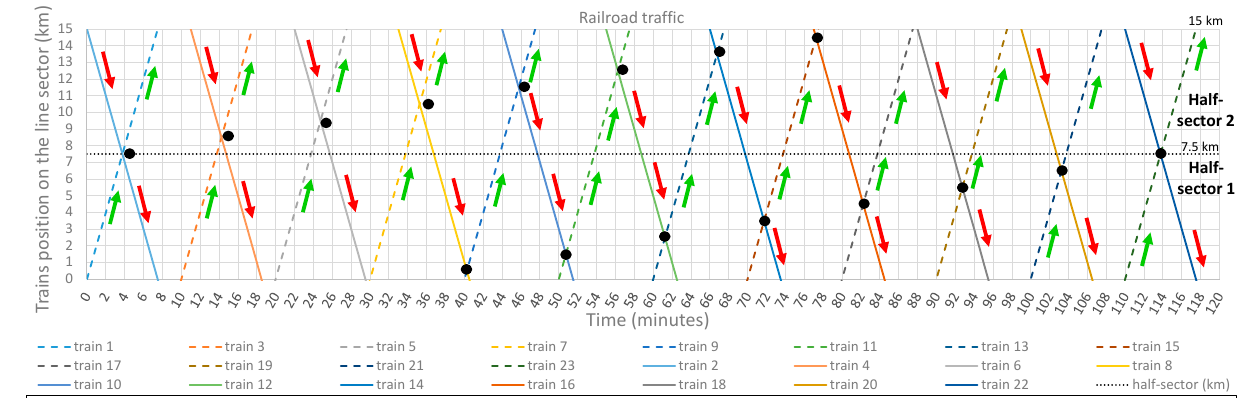
Figure 12. Railroad traffic considering the circulation of 23 trains over a time span of 2 h.